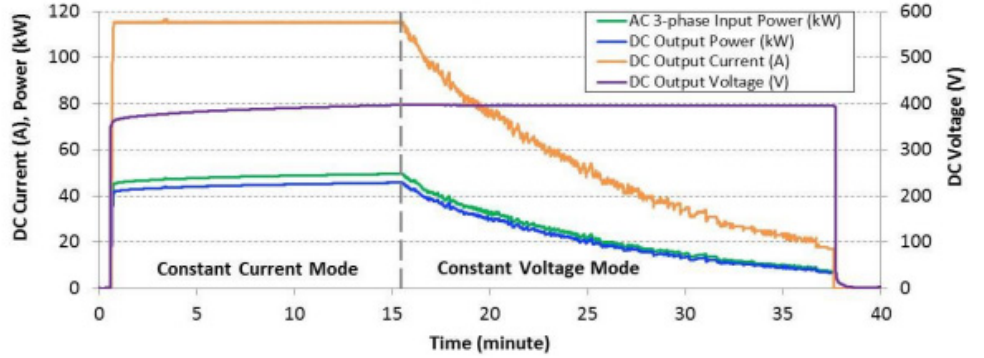
Figure 11. Fast charge event showing constant current, followed by constant voltage. (Reprinted with permission from Ref. [152]. Copyright 2016 INL.)